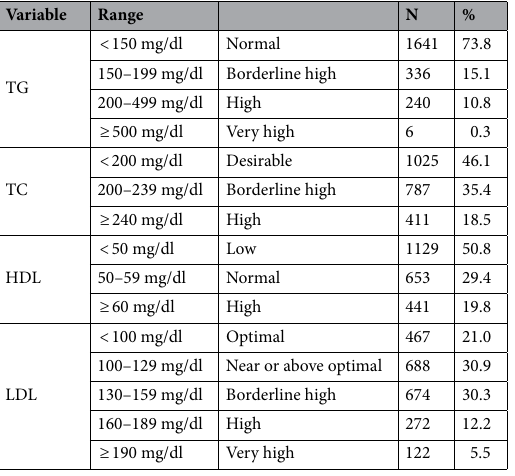
Table 2. Details of lipid abnormalities based on ATP III cut-offs. N, number; TG, triglyceride; TC, total cholesterol; HDL, high-density lipoprotein; LDL, low-density lipoprotein.